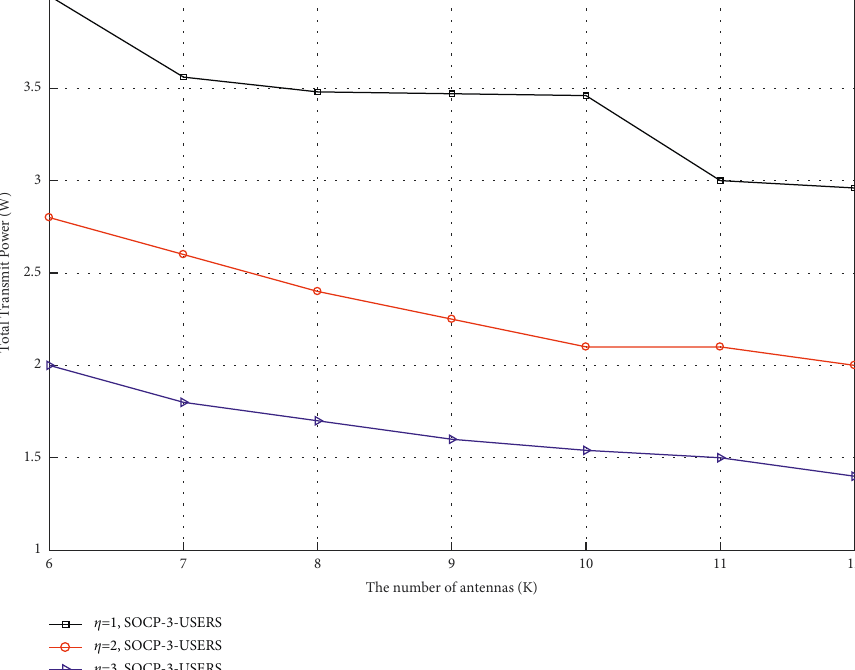
Figure 6: The optimal total transmission power versus the number of transmit antennas, with c � 1 and ζ �